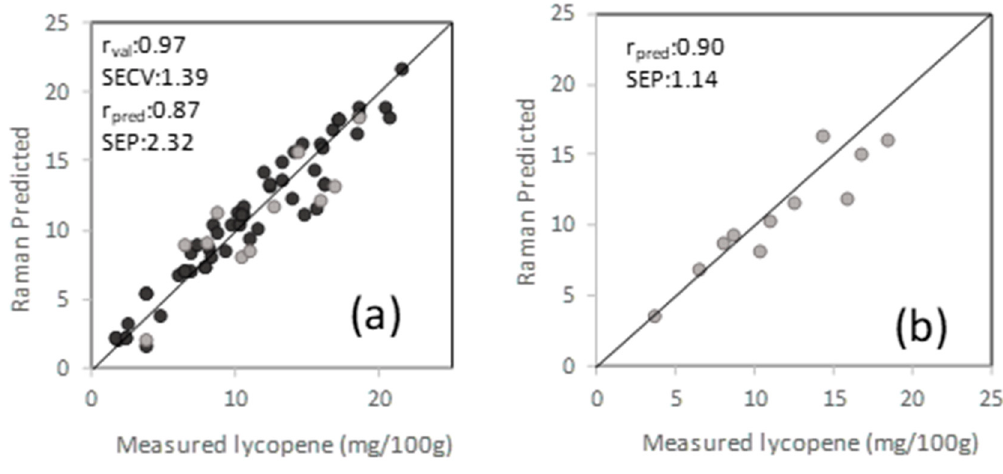
Figure 5. Regression model for all-trans-lycopene quantification for PLS ( a ) and artificial neural network (ANN); ( b ) black representing calibration set, and gray representing external validation test set.